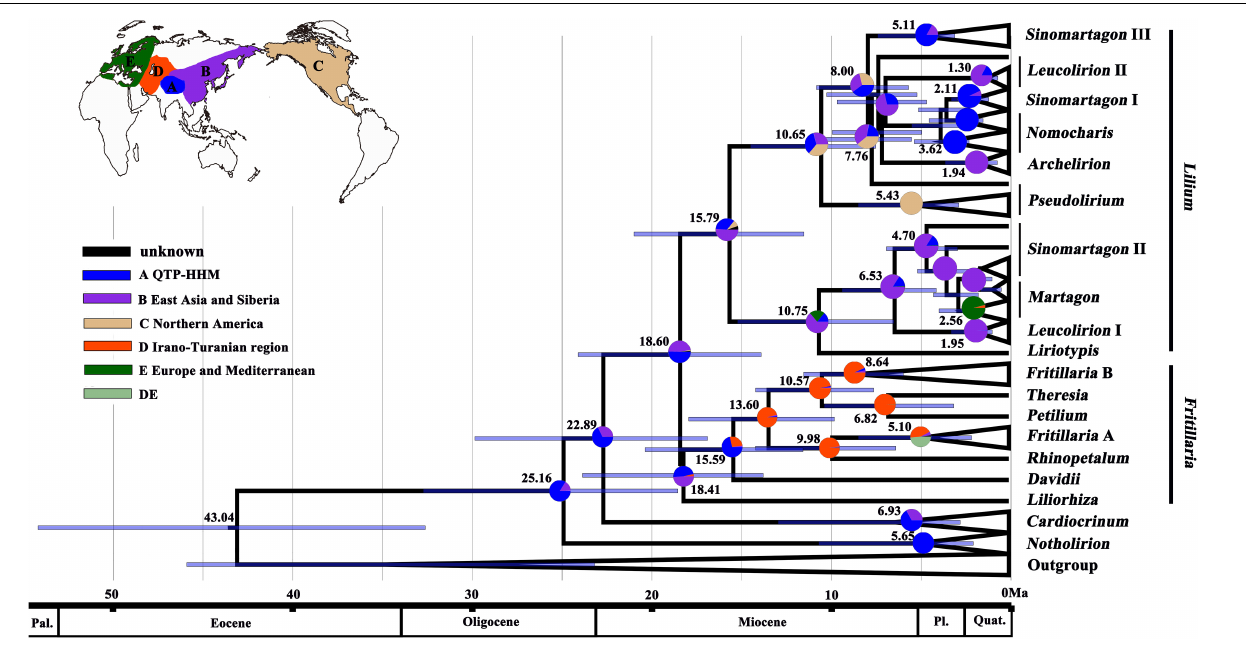
FIGURE 3 | Reconstructions of the ancestral area based on plastome-based phylogeny of Lilieae (see Figure 1A ). Pie charts show proportions of inferred ancestral ranges, pie slice colors to regions defined in the caption and inset world map. Mean divergence ages are given on nodes (see Figure 2 ). Bars on nodes indicate the 95% HPD of divergence